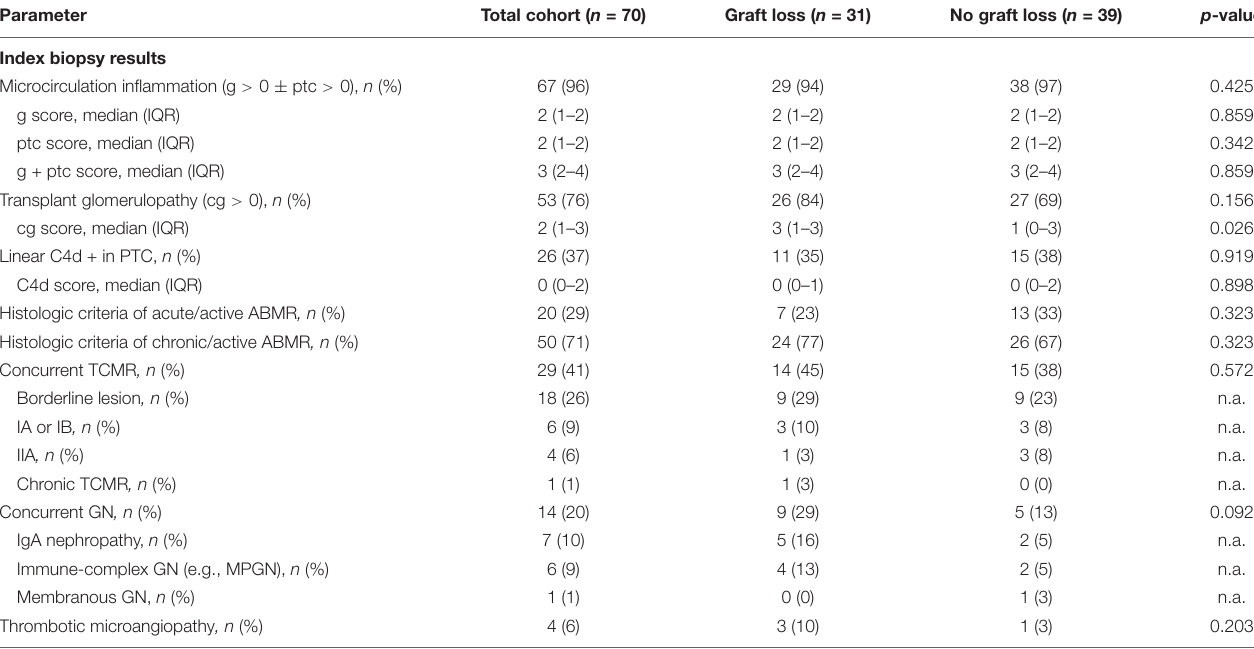
TABLE 3 | Index biopsy